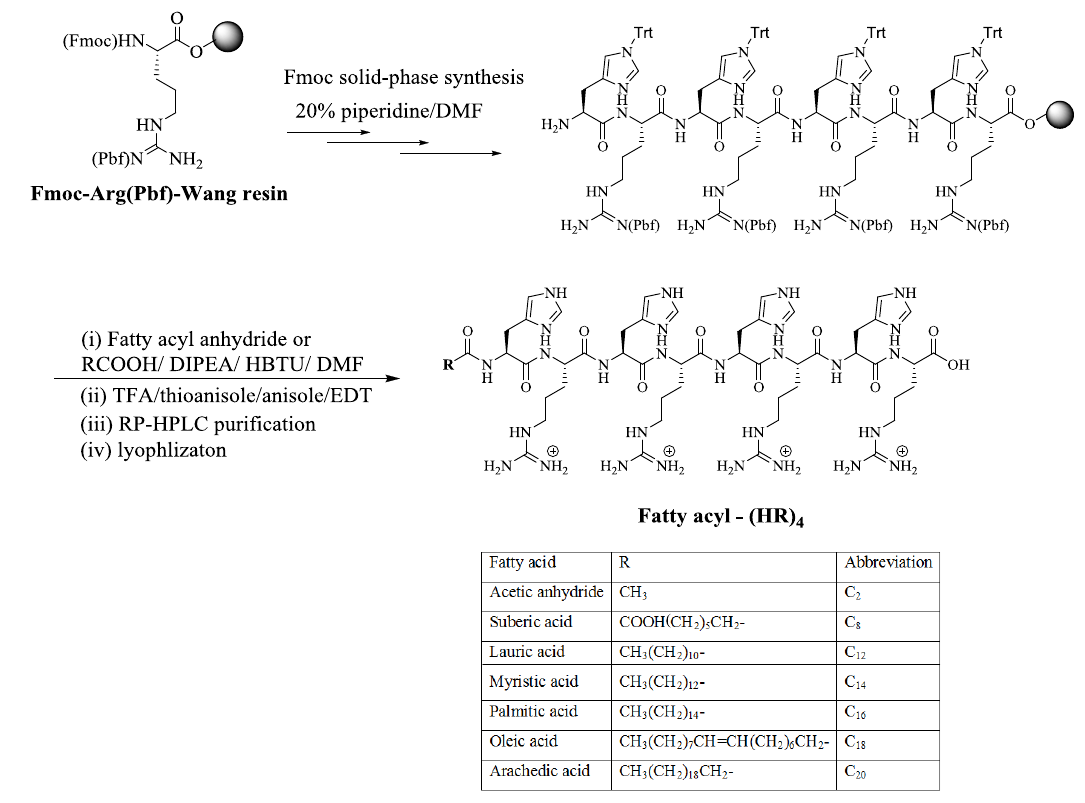
Scheme 2. Synthesis of fatty acyl conjugates of linear (HR) 4 peptides.